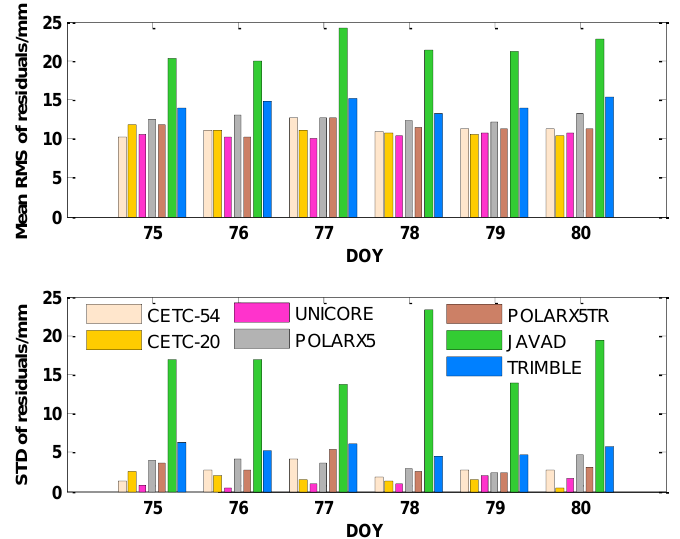
Figure 6. Carrier phase residual RMS of each station-satellite pair derived from the GPS POD. The top panel is the mean residuals of receivers on different stations, and the bottom panel is their STD.